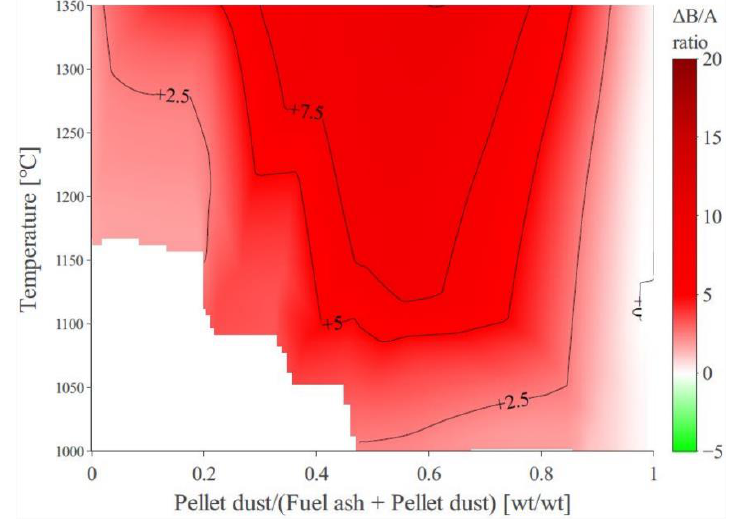
Figure 8. Plot of ∆ (B / A) comparing the level of basicity / acidity of the melt of coal with that of raw stem Figure 8. Plot of Δ(B/A) comparing the level of basicity/acidity of the melt of coal with that of raw wood when mixed with pellet dust. ∆ (B / A) = (B / A) stem wood − (B / A) coal . Contours indicate ∆ (B / stem wood when mixed with pellet dust. Δ(B/A) = (B/A) stem wood − (B/A) coal . Contours indicate Δ(B/A).